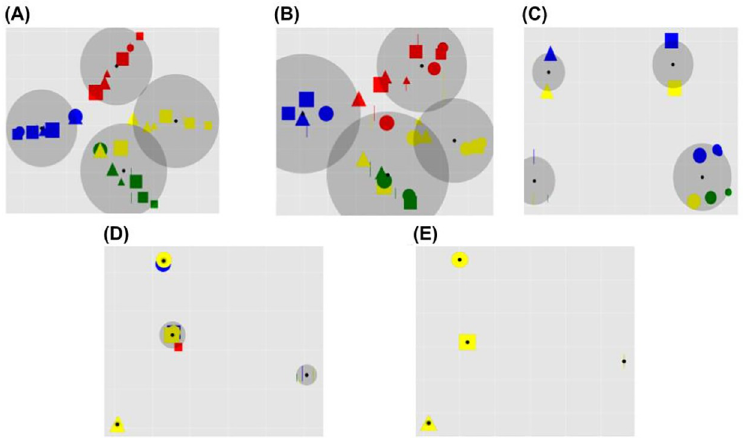
Fig 8. Shape sorting category: Reconstructed input. Principal components of the reconstructed image representations in the case of the shape sorting rule and in correspondence to different levels of RL. Note that, in case of overlap, the yellow inputs appear at the top and hide others due to technical factors (we plot the yellow inputs at the end). The plots are drawn as in Fig